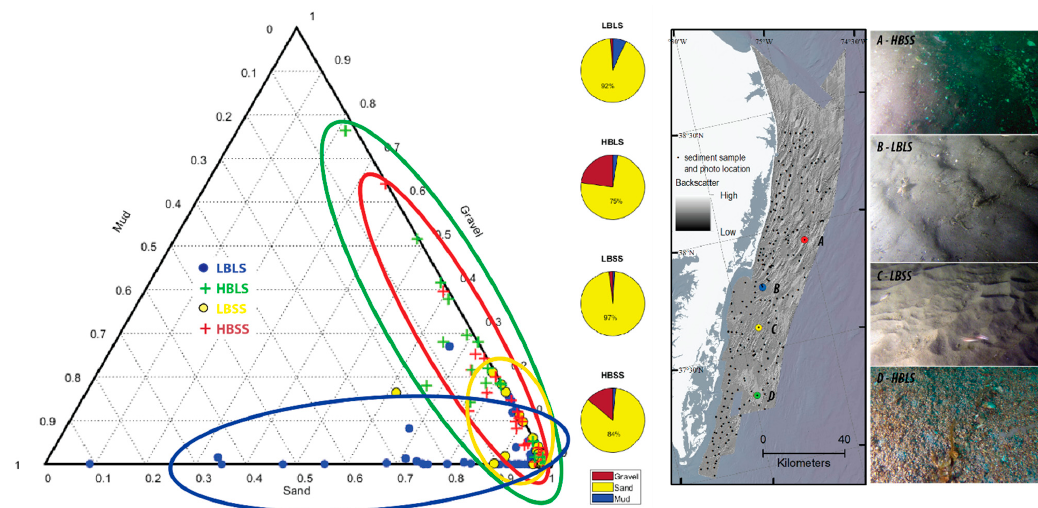
Figure 4. Ternary diagram depicts the sediment samples within each class. Ellipses are drawn around the majority of samples within each class to highlight the representative sediment signature associated with each. The four pie charts represent the average sediment composition in each class: LBLS, high backscatter areas with low seafloor slopes (HBLS), low backscatter areas with steep slopes (LBSS), and high backscatter areas with steep slopes (HBSS). The map and photos on the right-hand side show the sediment sample and photo locations with representative seafloor photos, one for each class.